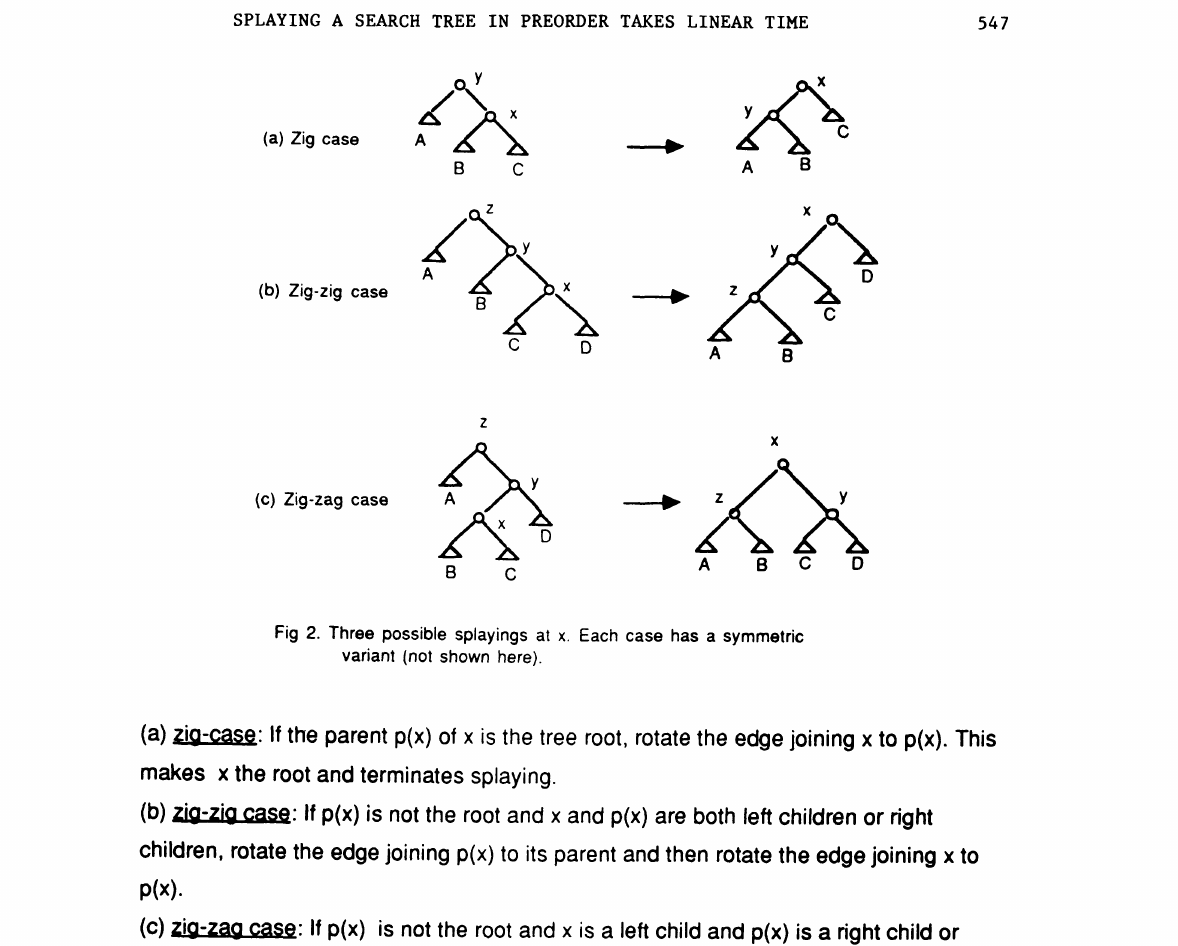
Fig 2. Three possible splayings at x. Each case has a symmetric variant (not shown